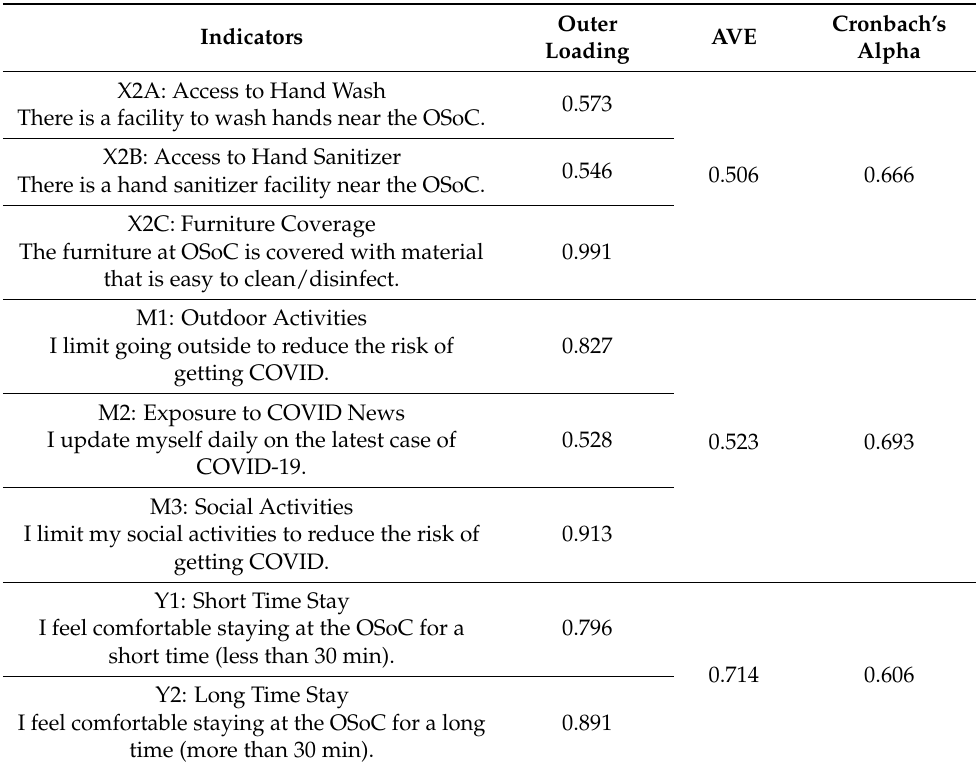
Table 3. Measurement Model Evaluation: Reflective